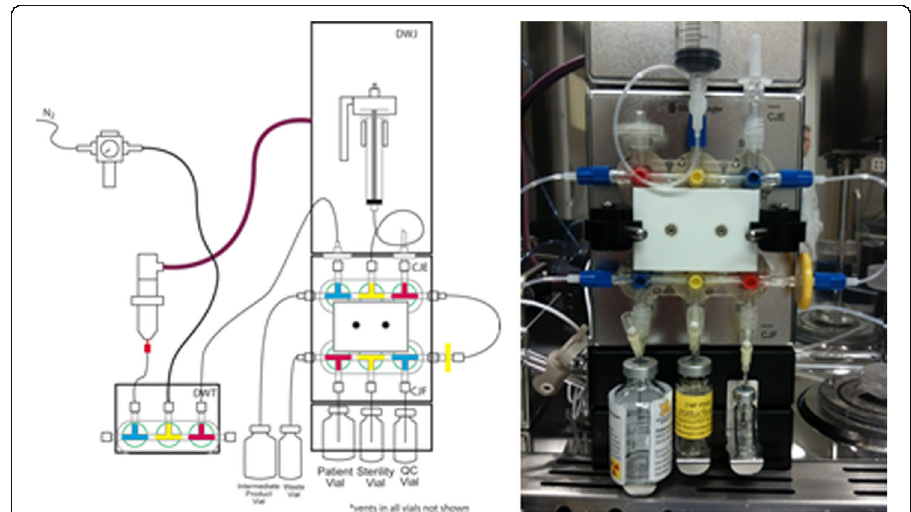
Fig. 4 Modular Lab Automated Dispensing